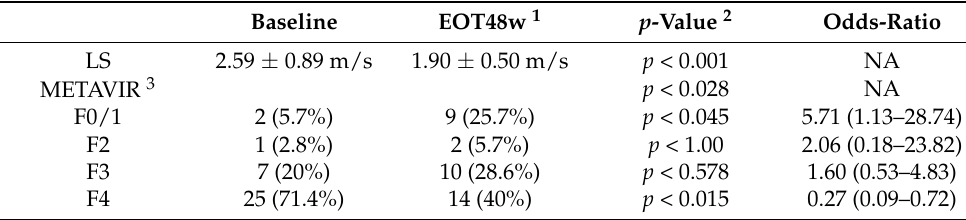
Figure 4. The boxplots demonstrate the improvement of liver fibrosis following antiviral treatment. Liver fibrosis was classified into four METAVIR stages (F0/1, F2, F3, F4) based on the SWE measurement. The post-treatment measurement was performed 48 weeks after the completion of antiviral treatment. We detected significantly improved fibrosis and a lower proportion of cirrhotic cases after successful direct-acting antiviral (DAA) therapy. Table 1. Comparison between pre- and post-treatment liver stiffness and METAVIR